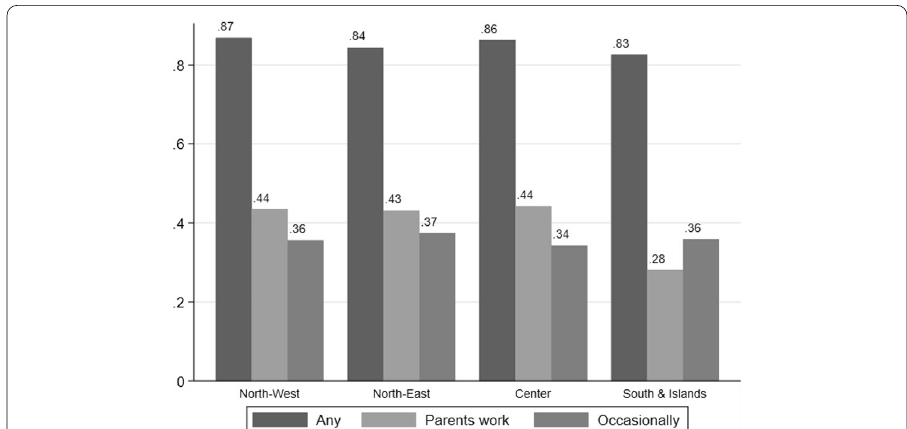
Fig. 1 Proportion of grandmothers providing childcare under different circumstances, by area of residence (unweighted data). Source : Authors’ elaborations on Multipurpose surveys on Families and Social Subjects— ISTAT, 2003, 2009, 2016. N =